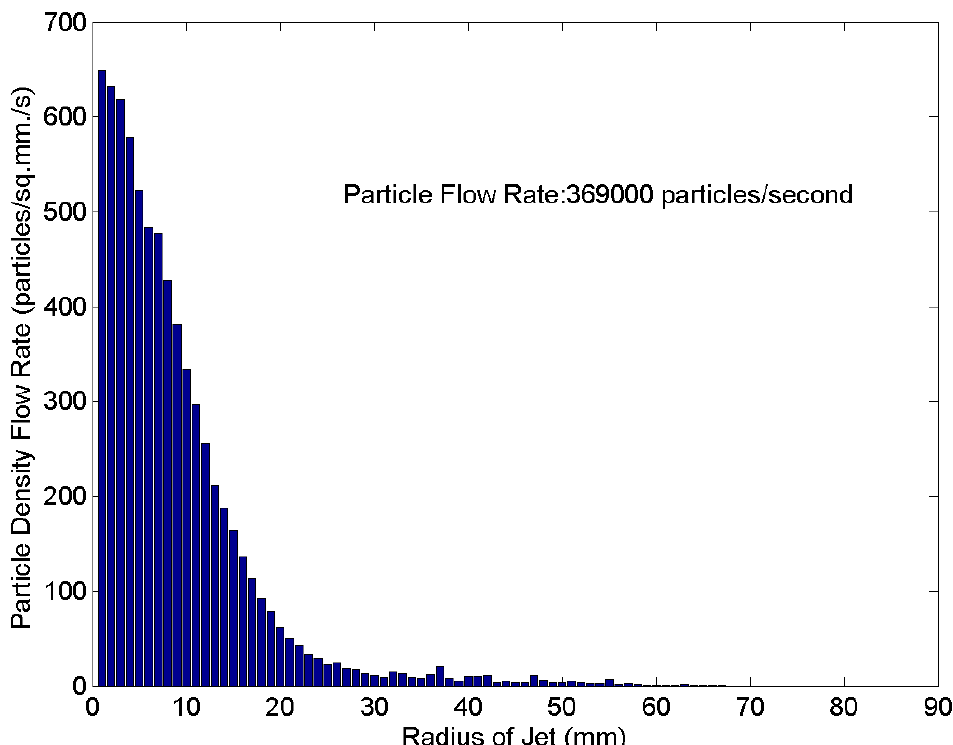
Figure 18. Experiment 2: Radial particle distribution at 20 cm from origin of annular air jet. Exposure t ime: 400 μs .